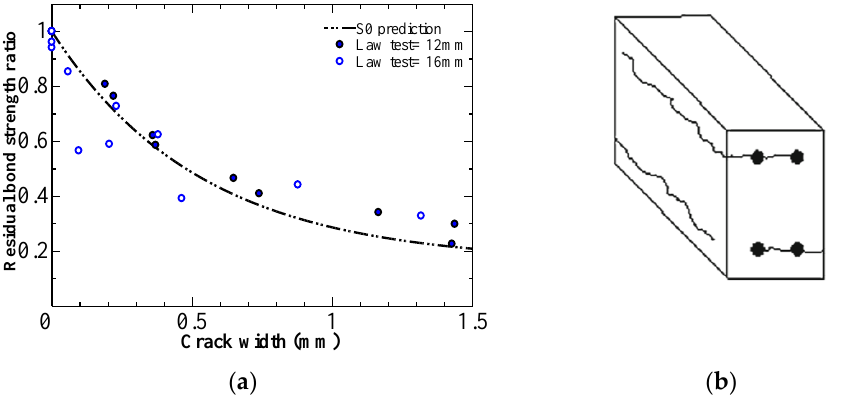
Figure 16. Comparison of the proposed formulas with study by Law et al.: ( a ) S0 prediction compared with specimen by Law et al.; ( b ) typical corrosion-induced cracks in specimen by Law et al. [16].